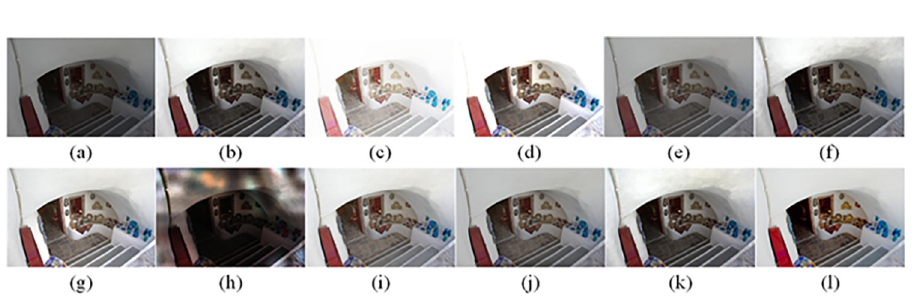
Fig 21. Comparisons of the ten algorithms in enhancing low-light image 11. (a) low-light image (b) AGCWD (c) Al-Ameen (d) BHE2PL (e) BIMEF (f) BPDHE (g) LIME (h) MSRCR (i) NPEA (j) SRIE (k) OURS (l) Normal light image.